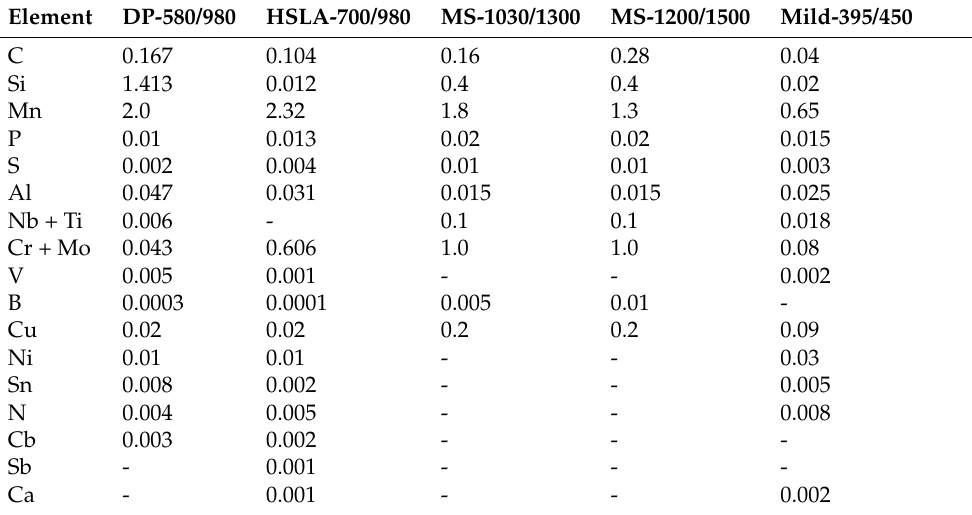
Table 1. Chemical composition of the steel sheets measured in mass percentage.